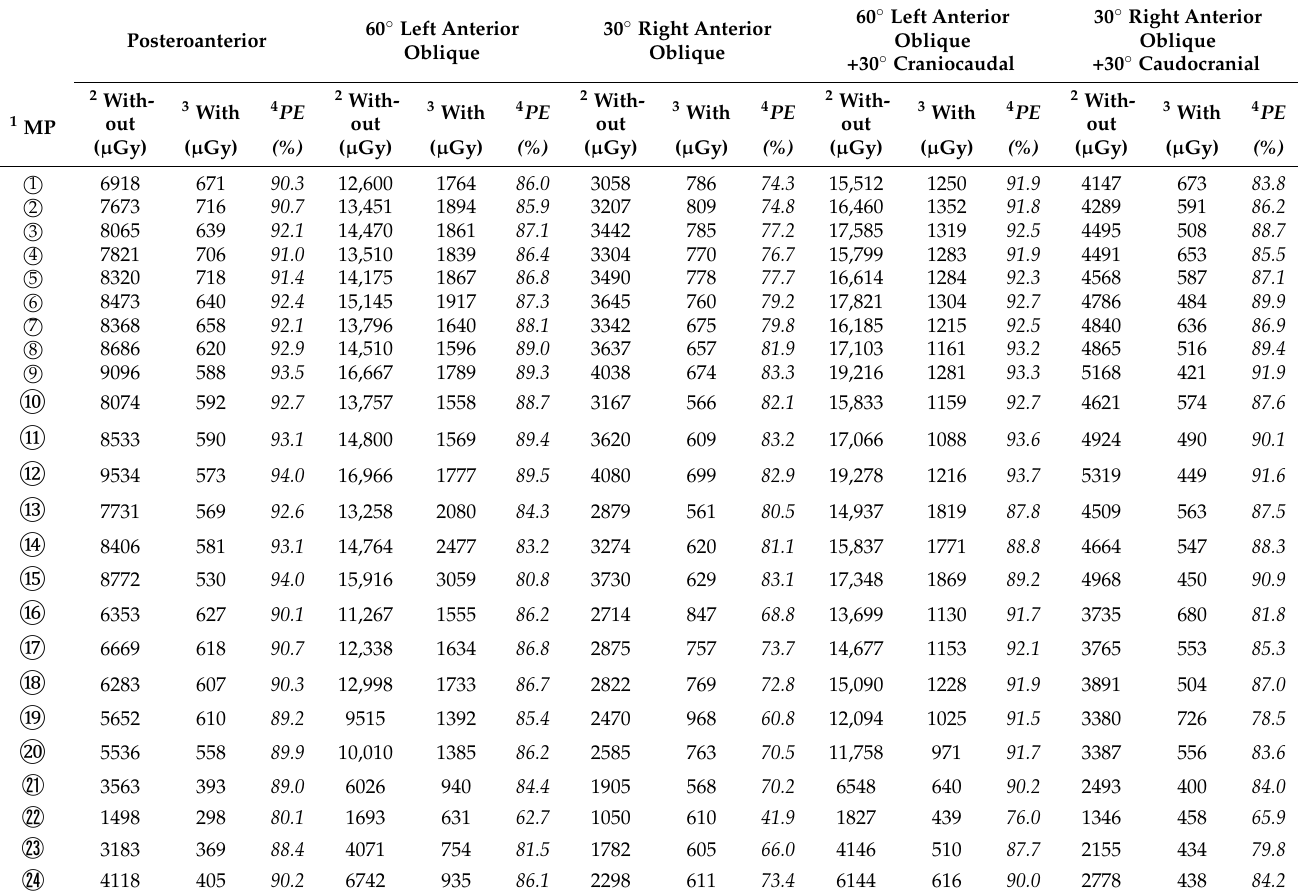
Table 2. Summary of the phantom study.